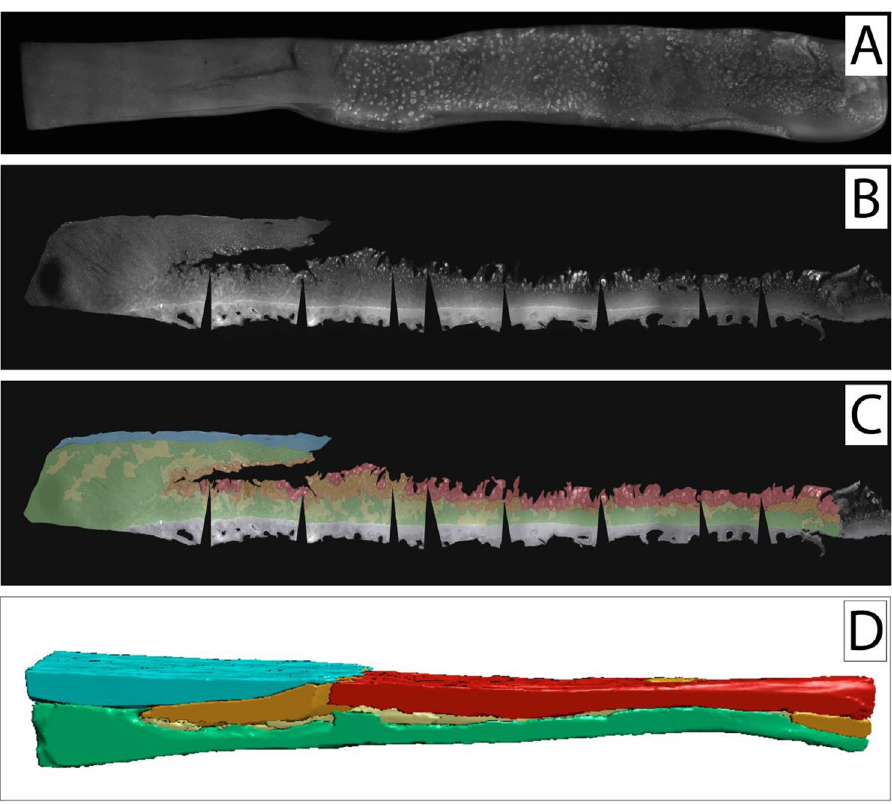
Figure 3. Top-down ( A ) and side view ( B , C ) of cartilage specimen I and the corresponding SR-µCT image rendering ( D ). ( C , D ) Zonal colour labelling of the predominant spatial chondrocyte arrangement: blue— superficial zone, green—single strings, yellow—double strings, orange—small clusters, red—large clusters, purple—diffuse, grey—subchondral bone. On the left side, in macroscopically intact cartilage, an intact superficial zone with underlying single strings with few areas of double strings can be seen. On the right side, the eroded remaining cartilage shows large clusters in the defect area. Small clusters surrounded by double strings are embedded in the fissure that cuts deep at the transition between these two extrema. The µCT-image confirms these findings throughout all tissue layers also in the full width of the analysed sample. The black wedges are a digital artefact of straightening the image. This figure was created using MeVisLab (https:// www. mevis lab. de/ mevis lab), Adobe Photoshop CS6 (https:// www. adobe. com/ ch_ de/ produ cts/ photo shop. html) and Adobe Illustrator CS6 (https:// www. adobe. com/ ch_ de/ produ cts/ illus trator.